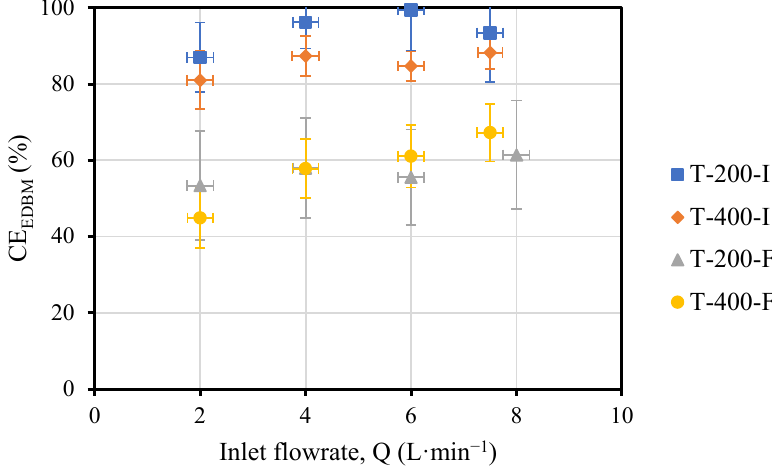
Figure 5. Profiles of the CE EDBM versus the flowrate for tests: ( a ) T ‐ 200 ‐ I; ( b ) T ‐ 400 ‐ I; ( c ) T ‐ 200 ‐ F; ( d ) T ‐ 400 ‐ F.